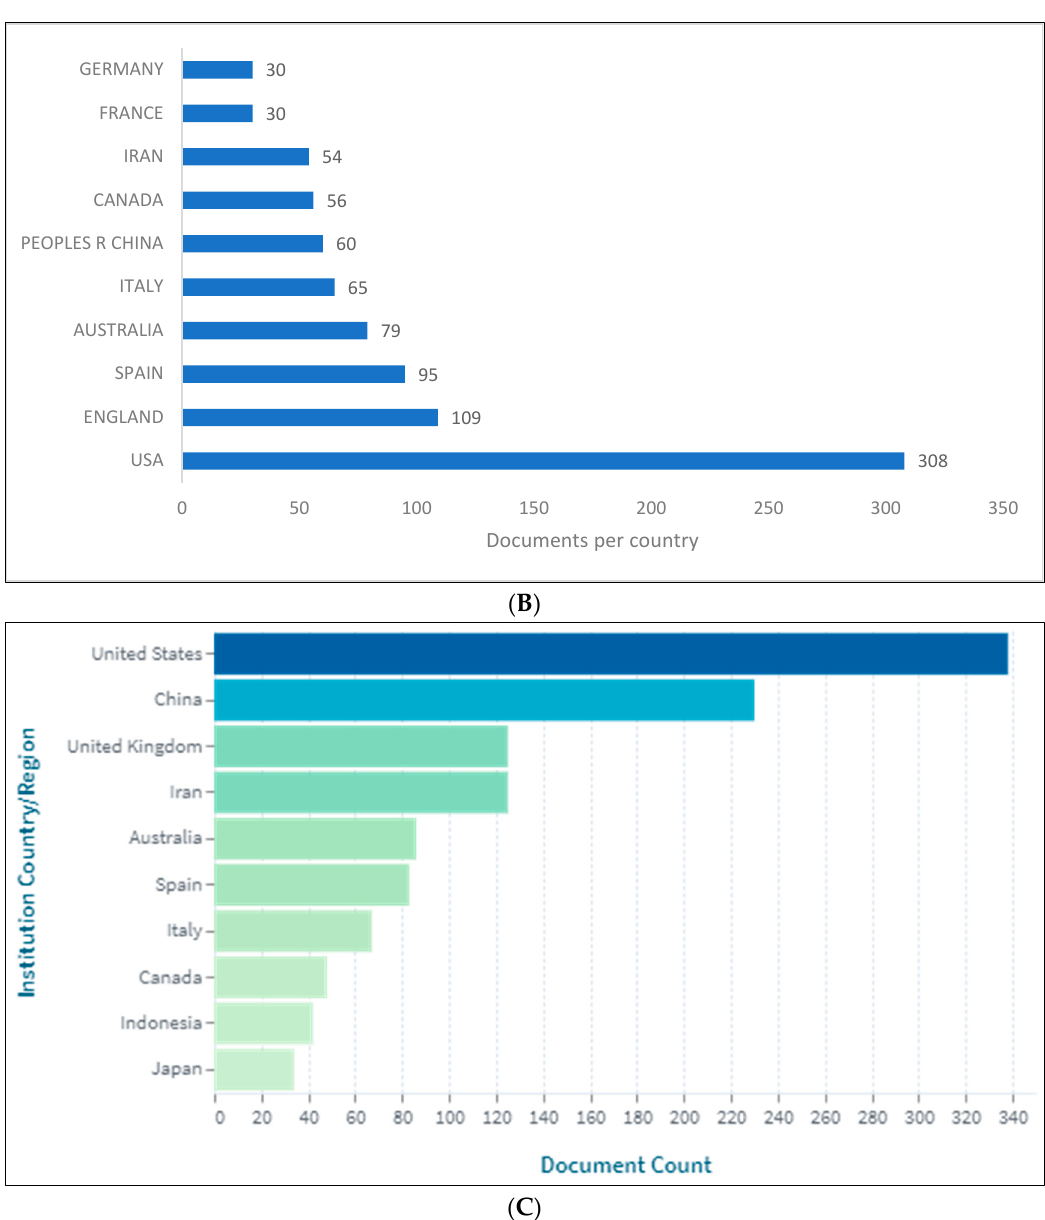
Figure 2. Pragmatic language development knowledge production size by country: ( A ) Scopus; ( B ) WOS; ( C ) Lens.